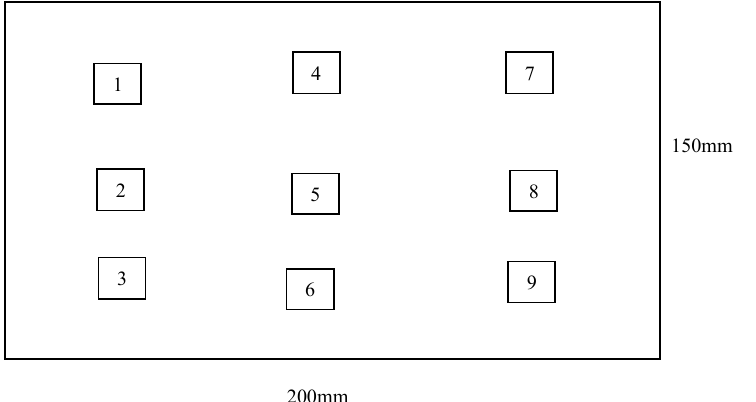
Figure 1. Schematic diagram showing the test location of the chemical composition sample.